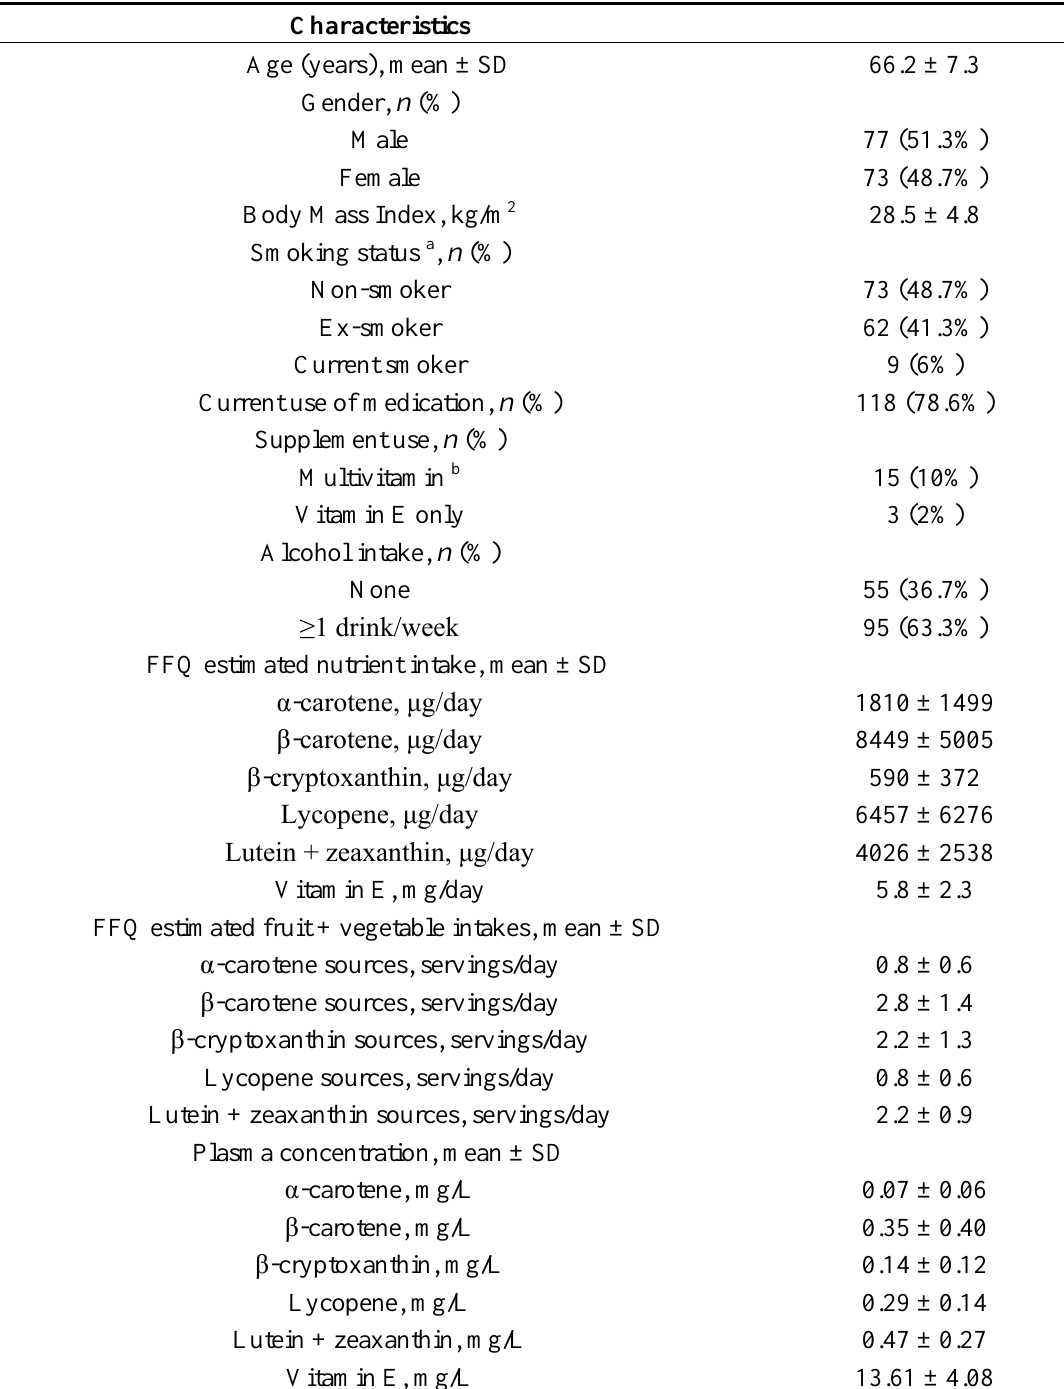
Table 1. Characteristics of Hunter Community Study participants ( n = 150) in a dietary validation